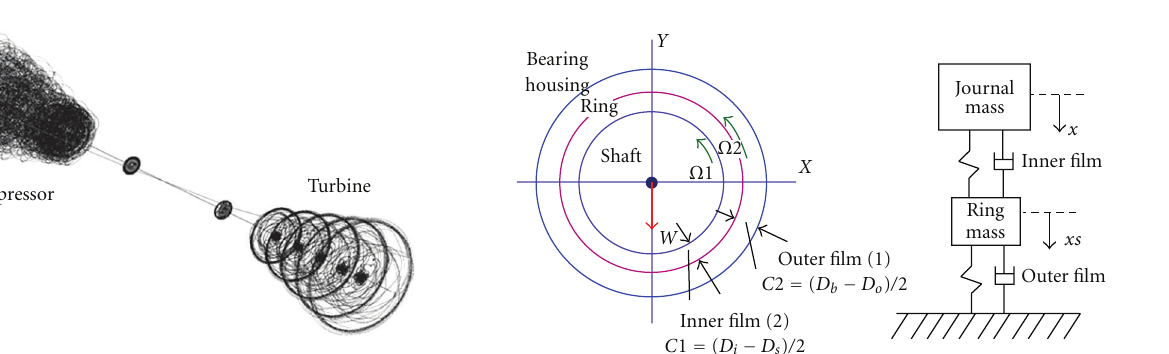
Figure 3: Numerical predictions of a typical turbocharger rotor transient response at speed 100,000 rpm [6]. Figure 4: Floating ring